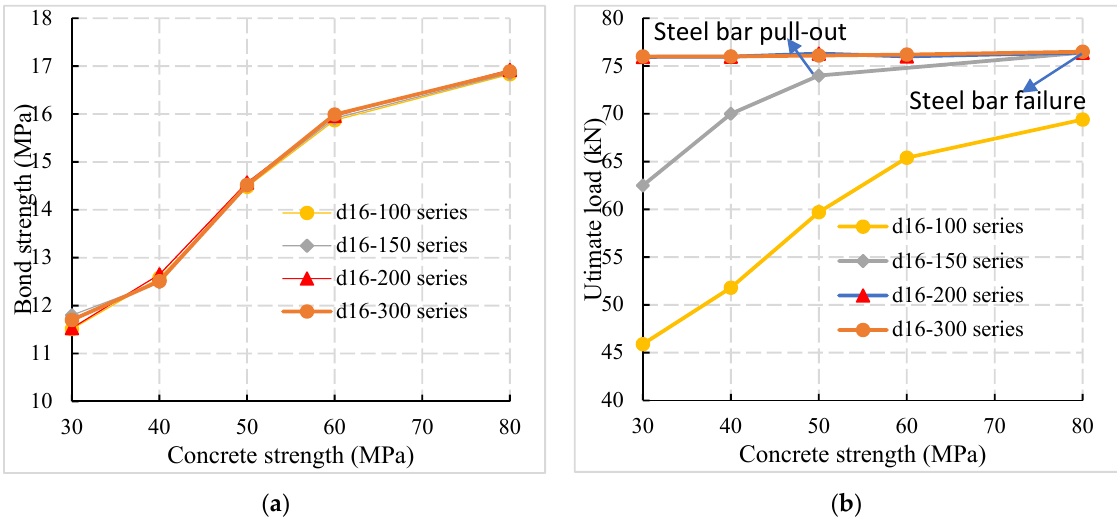
Figure 12. Influence of concrete strength grade. ( a ) Comparison of bond strength and concrete strength. ( b ) Ultimate load